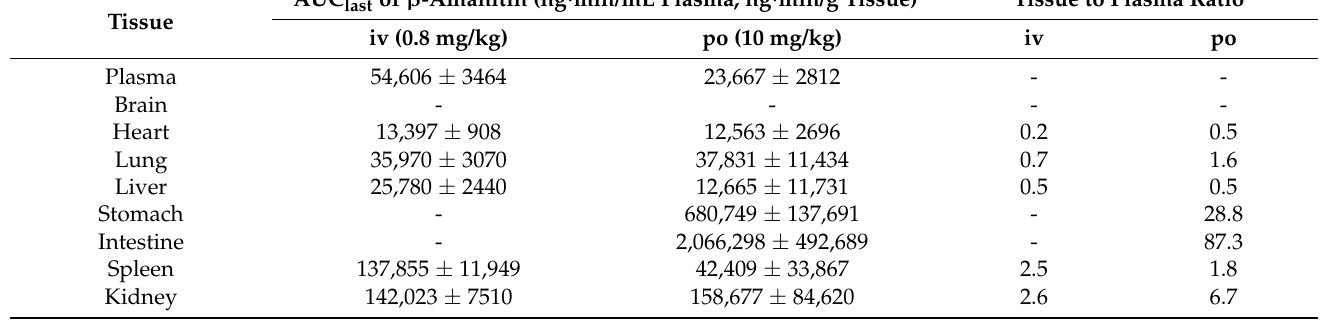
Table 4. The area under the plasma and tissue concentration–time curves (AUC last ) for β -amanitin in male ICR mice after intravenous (iv) and oral (po) administration of β -amanitin at doses of 0.8 or 10 mg/kg, respectively, (mean ± SD) ( n =